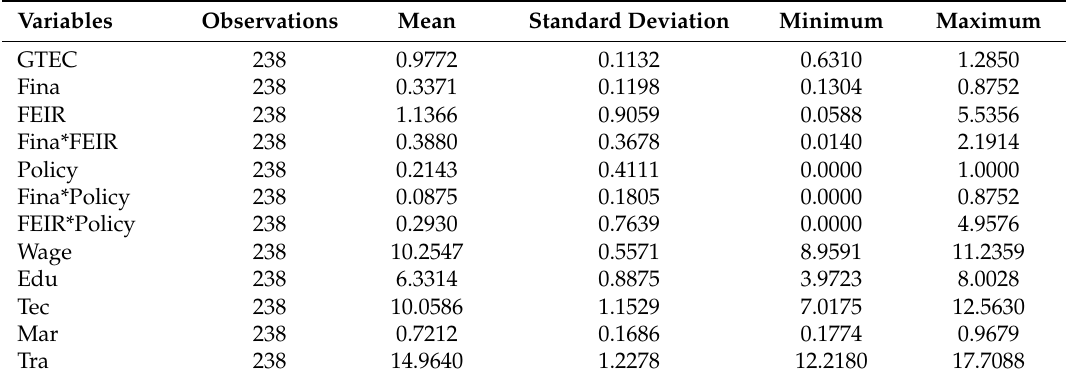
Table 3. Descriptive statistics of main